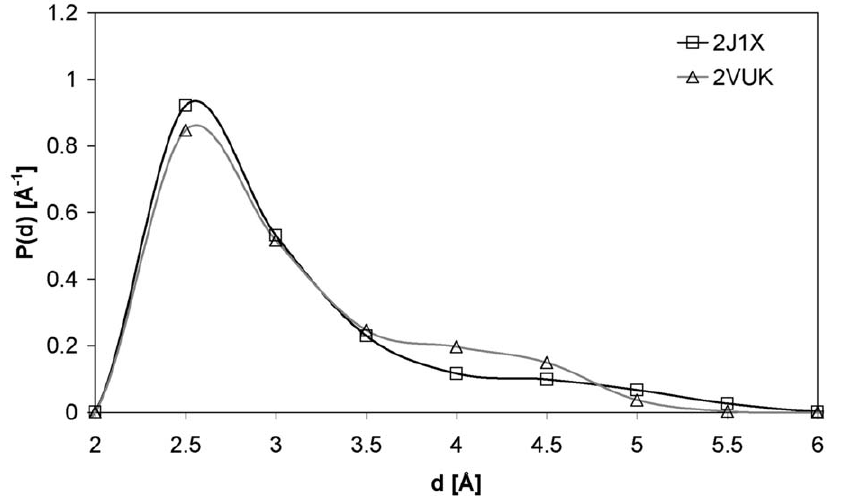
Figure 2. Distribution of the distance between the C=O oxygen of THR 155 and the oxygen of the nearest water molecule. We show this curve for pdb 2VUK (T-p53C-Y220C-PhiKan083; mean value of the distribution m =3.102 A˚ and deviation s =0.692 A˚) and 2J1X (T-p53C-Y220C; m =3.065 A˚ and s =0.736 A˚). In both cases we used 2000 configurations and water was modeled with the TIP5P model.